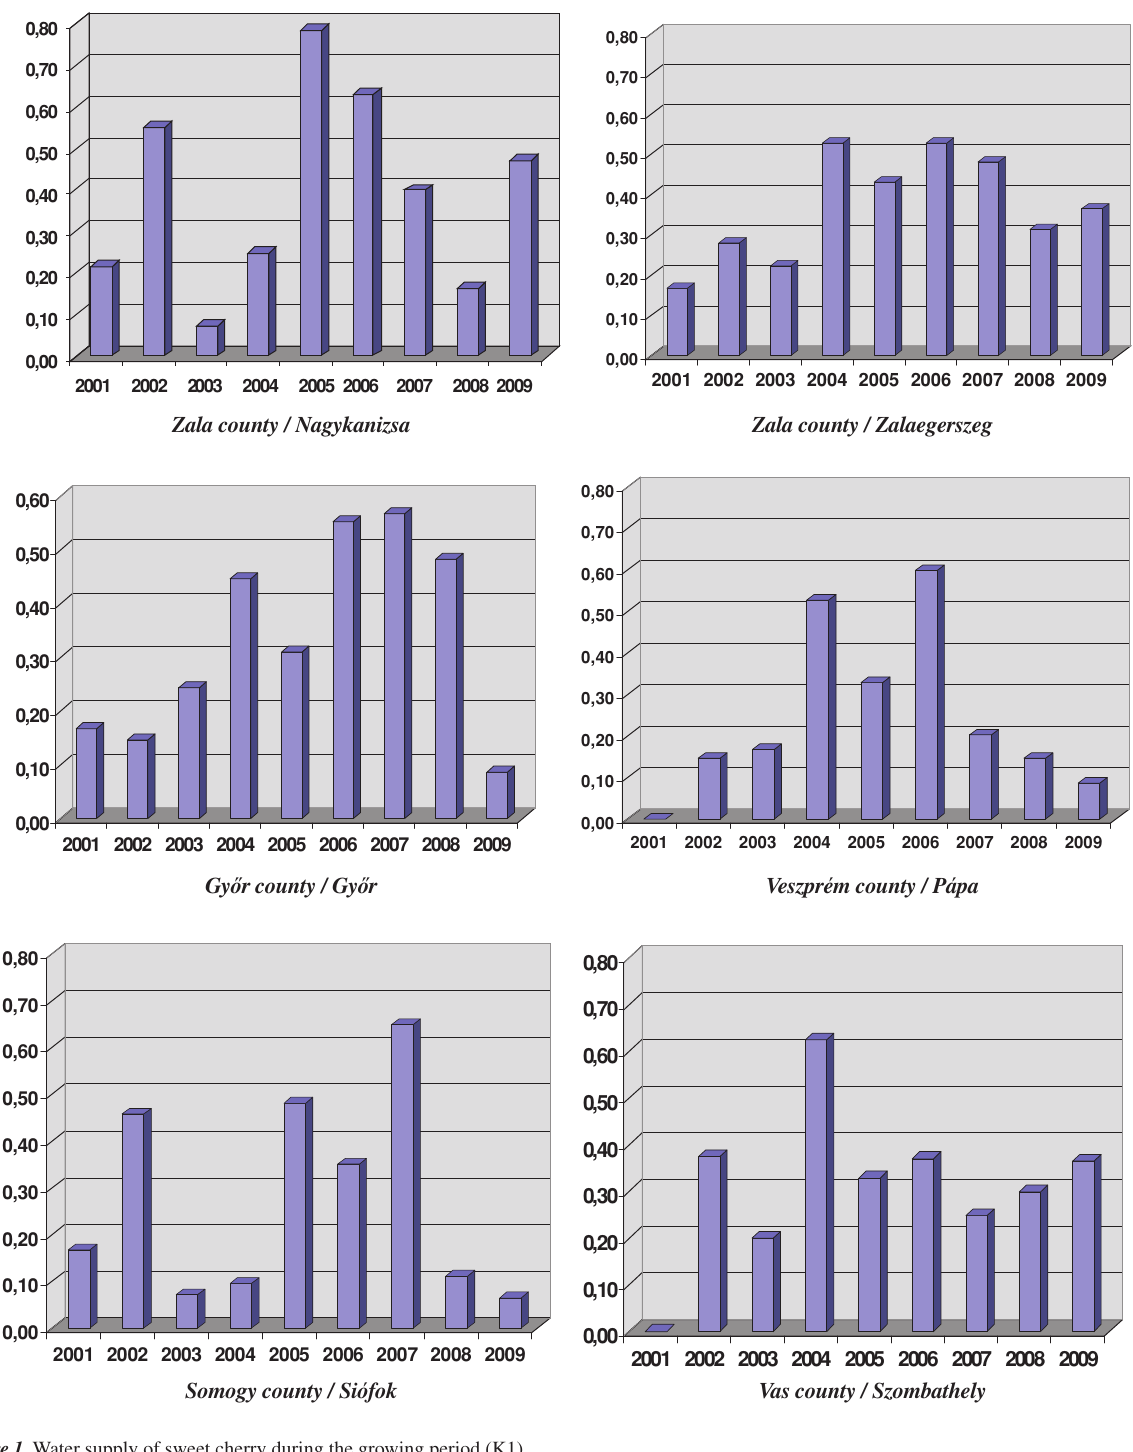
Figure 1. Water supply of sweet cherry during the growing period